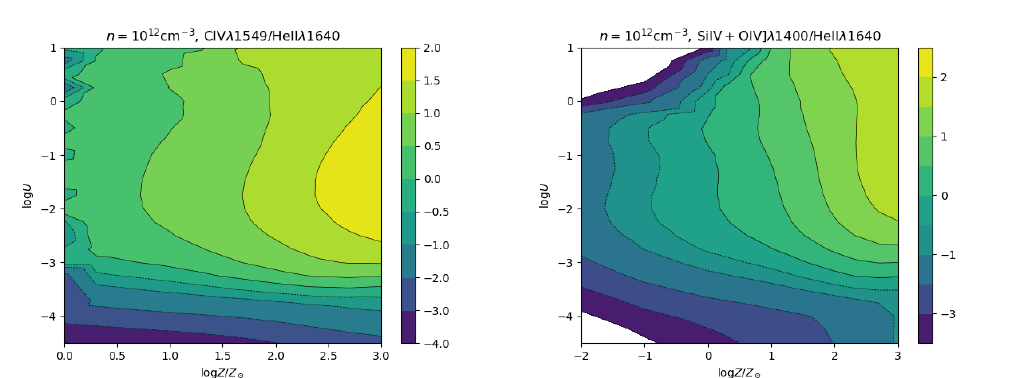
Figure 8. Dependence of the ratios C IV /He II λ 1640 and Si IV + O IV ] λ 1402/He II λ 1640 (in log) on Z and U